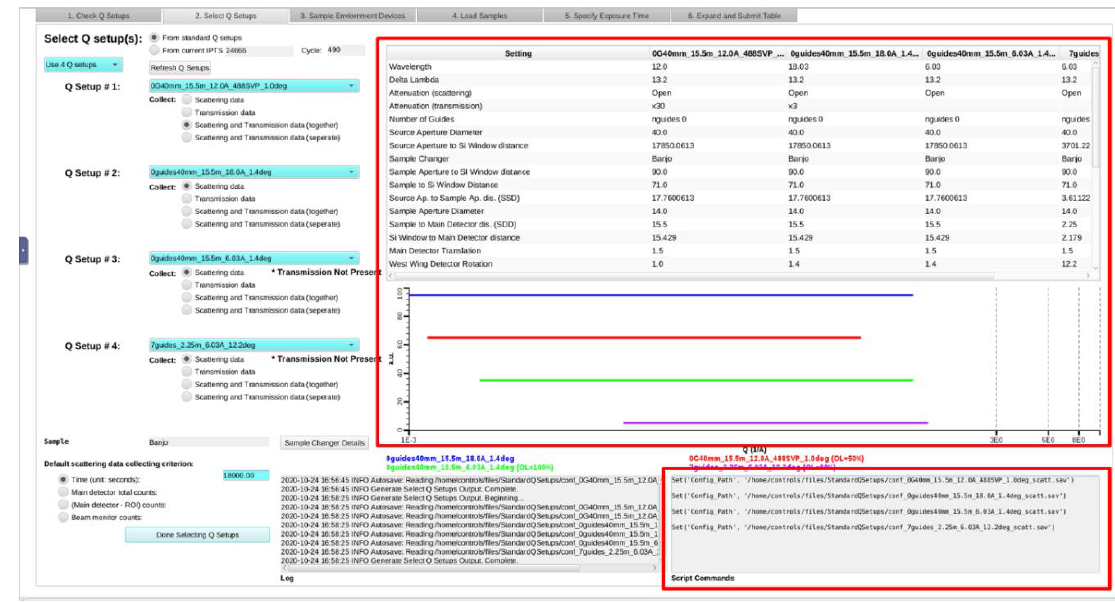
Figure 8. Friendly table view and visualization of Q-ranges (highlighted by the upper red rectangle box), scripting snippets generating with Q-range configurations selected (lower red box). The example shows up to four Q setups at the same time.